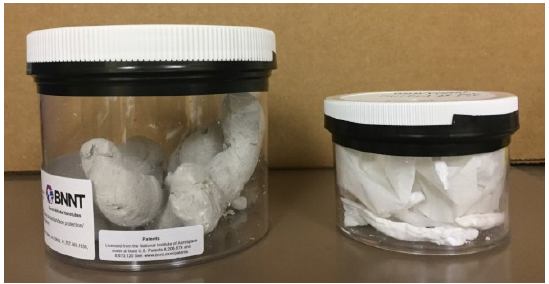
Figure 18. Photograph of 500-mg sample of as-received BNNT (left) and 500-mg sample of BNNT following purification at the National Institute of Aerospace (NIA) at 600 °C for 1 hour (right).